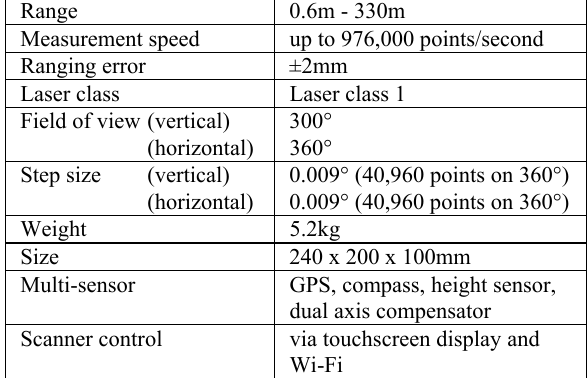
Table 2. Specifications of FARO Focus3D X 330